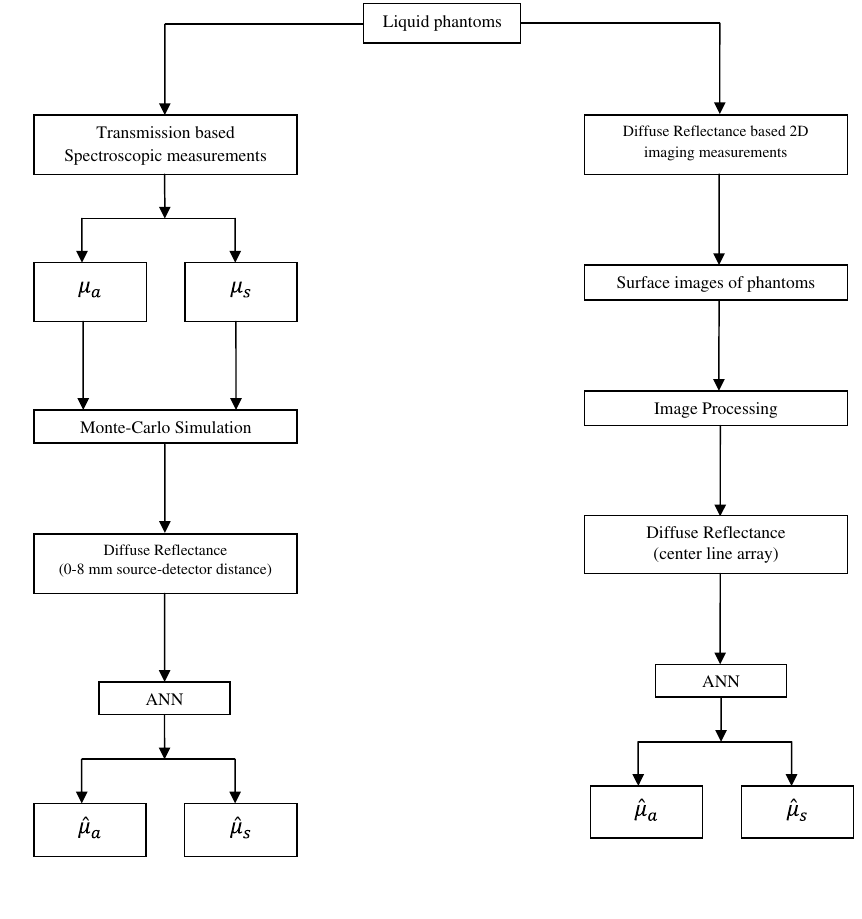
Fig. 4. General °owchart of this study.